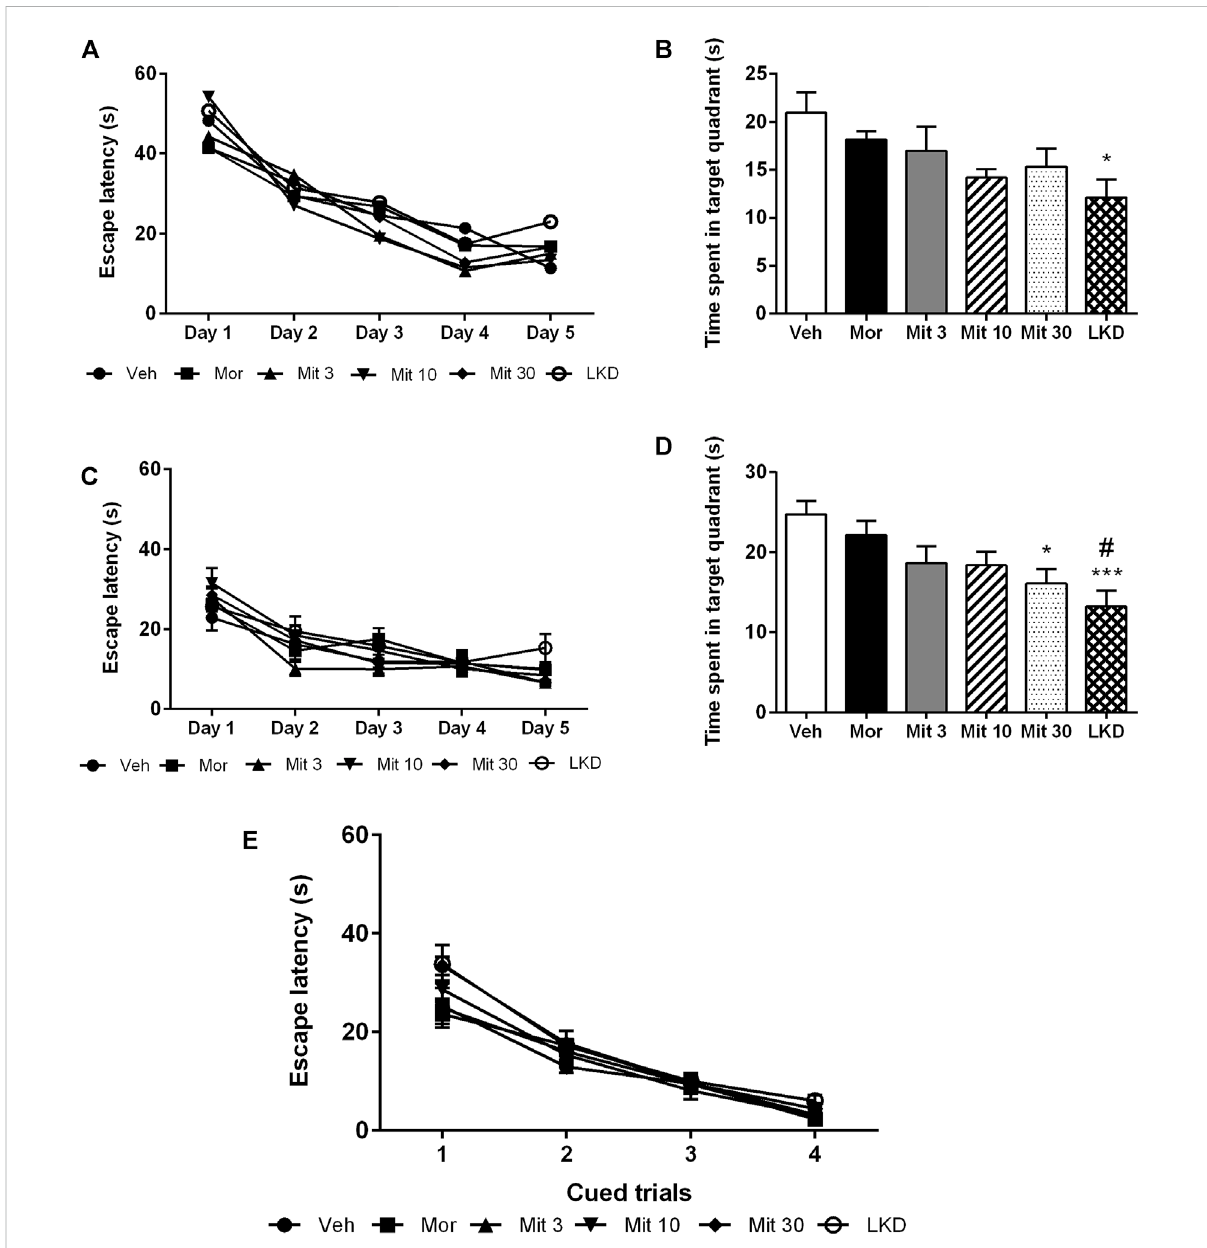
FIGURE 5 Effects of adolescent kratom exposure on the Morris water maze performance. (A) Escape latencies during acquisition trials, (B) Time spent in the target quadrant during probe trial, (C) Escape latencies during reversal learning, (D) Time spent in the target quadrant during reversal probe trial, and (E) Escape latencies in the presence of visible platform. Data are expressed as mean ± SEM ( n = 8 – 10). * p < 0.05, *** p < 0.001 against vehicle- treated group, # p < 0.05 against morphine-treated